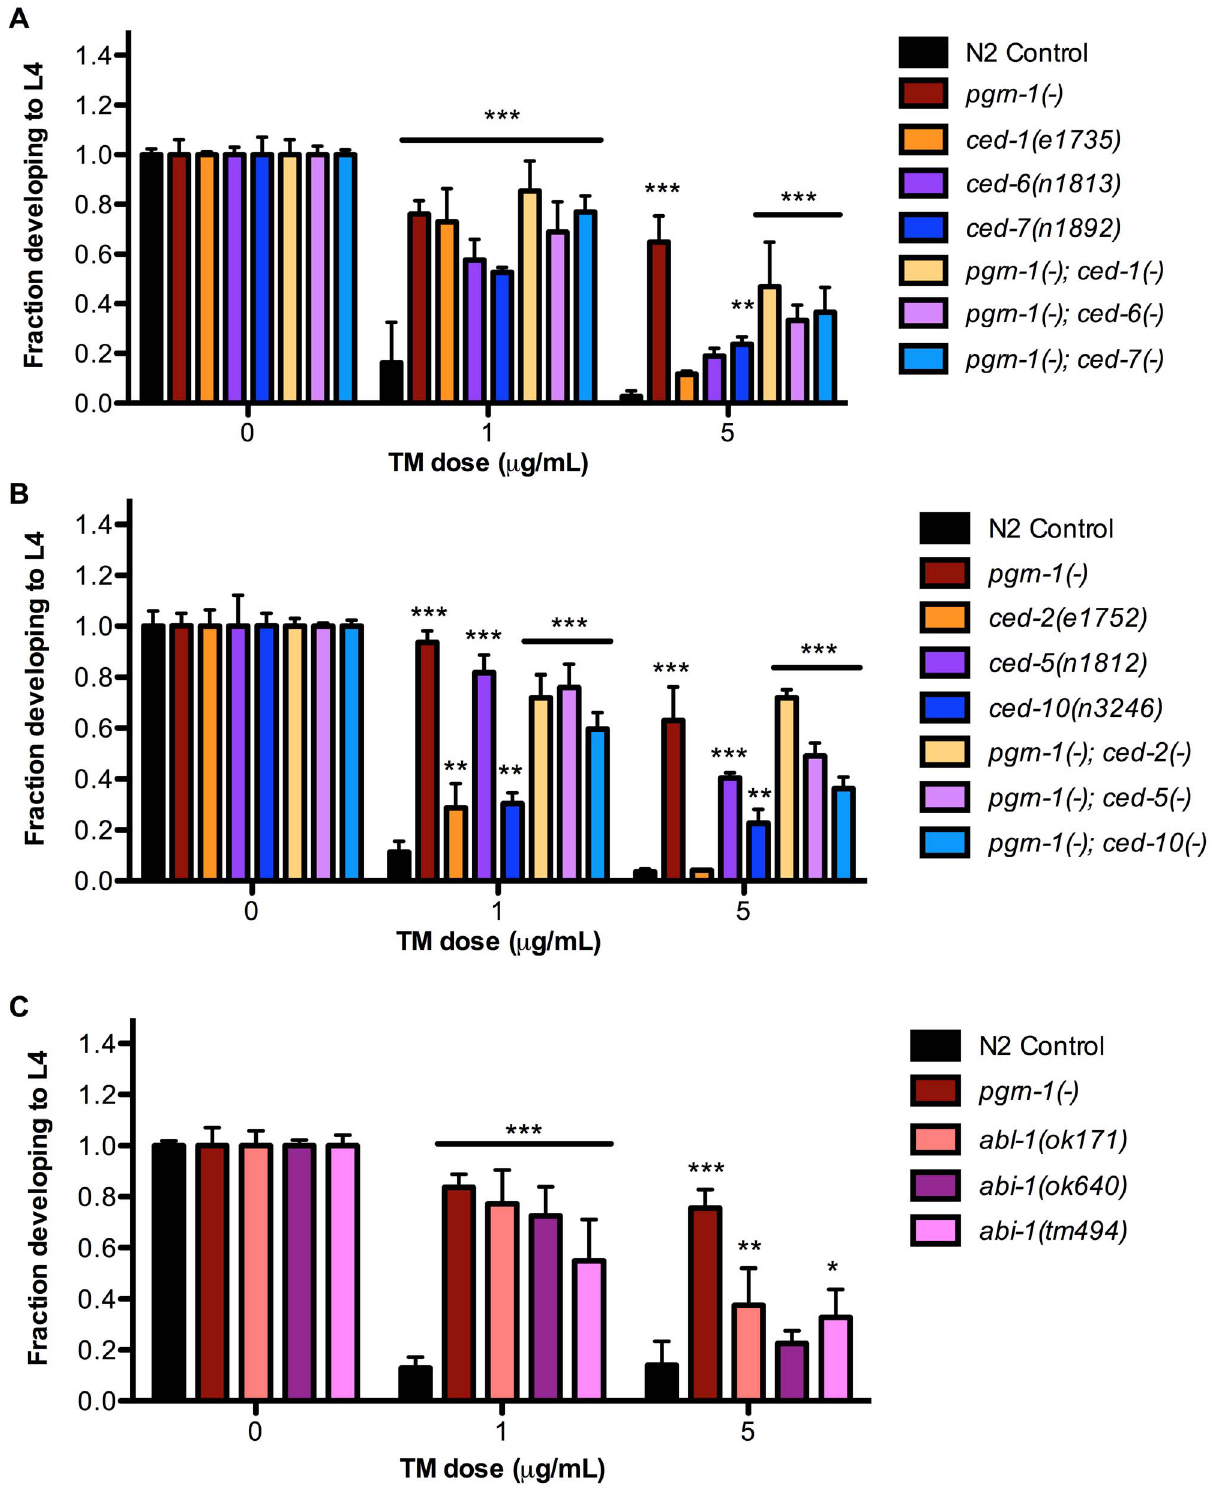
Figure 3. Engulfment mutations enhance ER stress resistance. (A) Mutations in ced-1(e1735), ced-6(n1813) and ced-7(n1892) with or without pgrn-1(tm985) in the background were tested for ER stress resistance by tunicamycin (TM) treatment. (B) Mutations in ced-2(e1752), ced-5(n1812) and ced-10(n3246) with or without pgrn-1(tm985) in the background were tested for ER stress resistance by tunicamycin treatment. (C) Mutations in abl- 1(ok171), abi-1(ok640) and abi-1(tm494) were tested for ER stress resistance by tunicamycin treatment. Results shown are representative of at least 2 experiments except in the case of (C) which was performed once. Error bars represent standard deviation. Statistical comparisons are to N2 control (ANOVA with Bonferroni post-tests). n.s. not significant, *p , 0.05, **p , 0.01, ***p , 0.001. For additional statistical data, see Table S3A, B, and D.